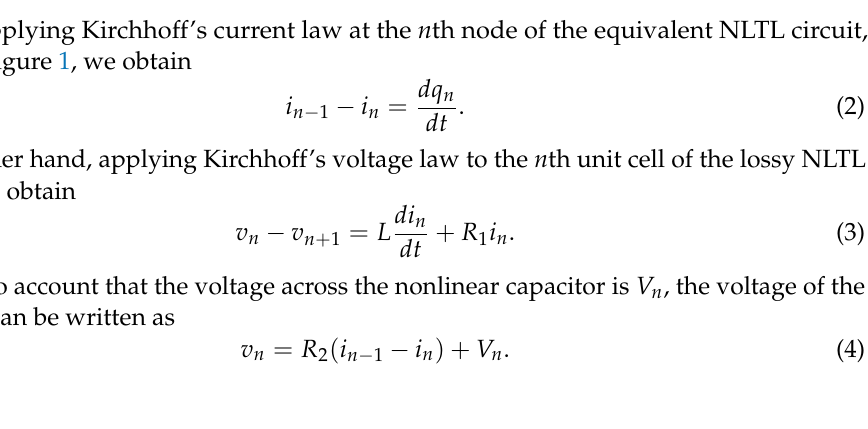
Figure 2. The fitted capacitance–voltage characteristic of the commercially available varactor [11]. Voltage